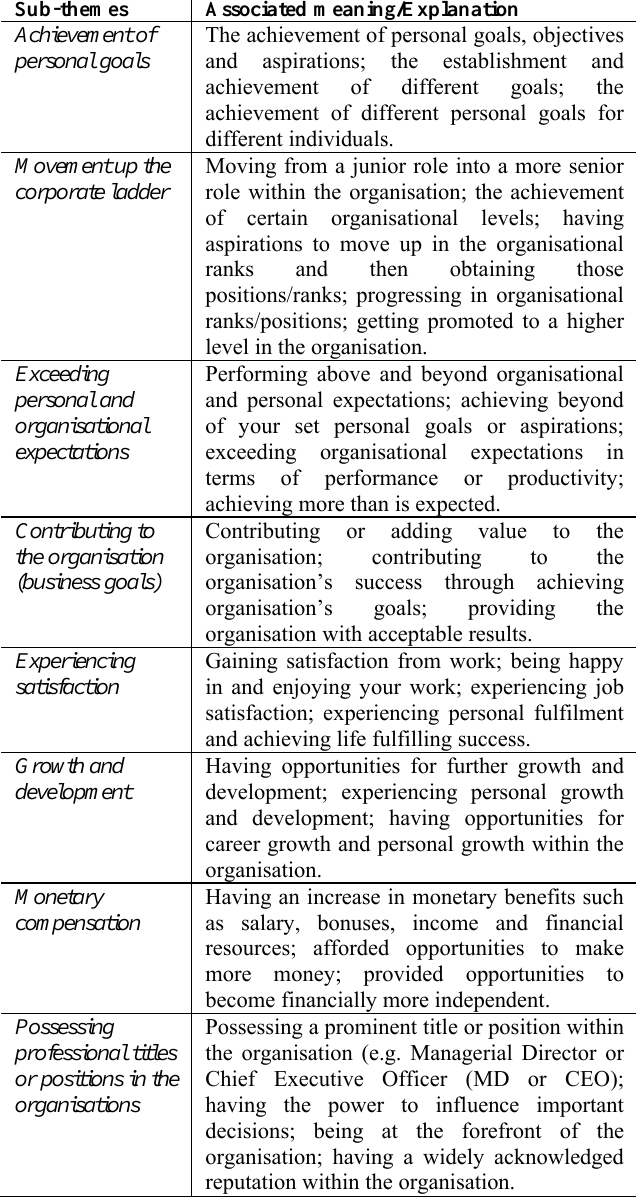
Table 1: General conceptualisation of career